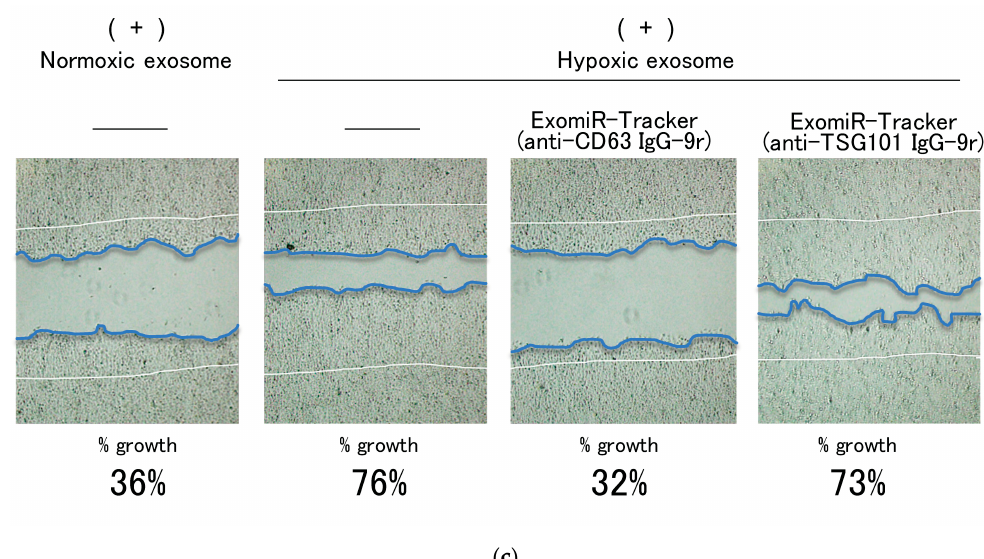
Figure 4. Successful inhibition of exosomal miRNA by ExomiR-Tracker in the recipient cells: ( a ) Evaluation of the inhibitory effects by ExomiR-Trackers on miR-21 by a luciferase assay. ( b ) Amount of exosomal miR21 under the hypoxic and normoxic conditions. ( c ) ExomiR-Tracker successfully inhibited exosomal miR-21 function in Cal27 cells.